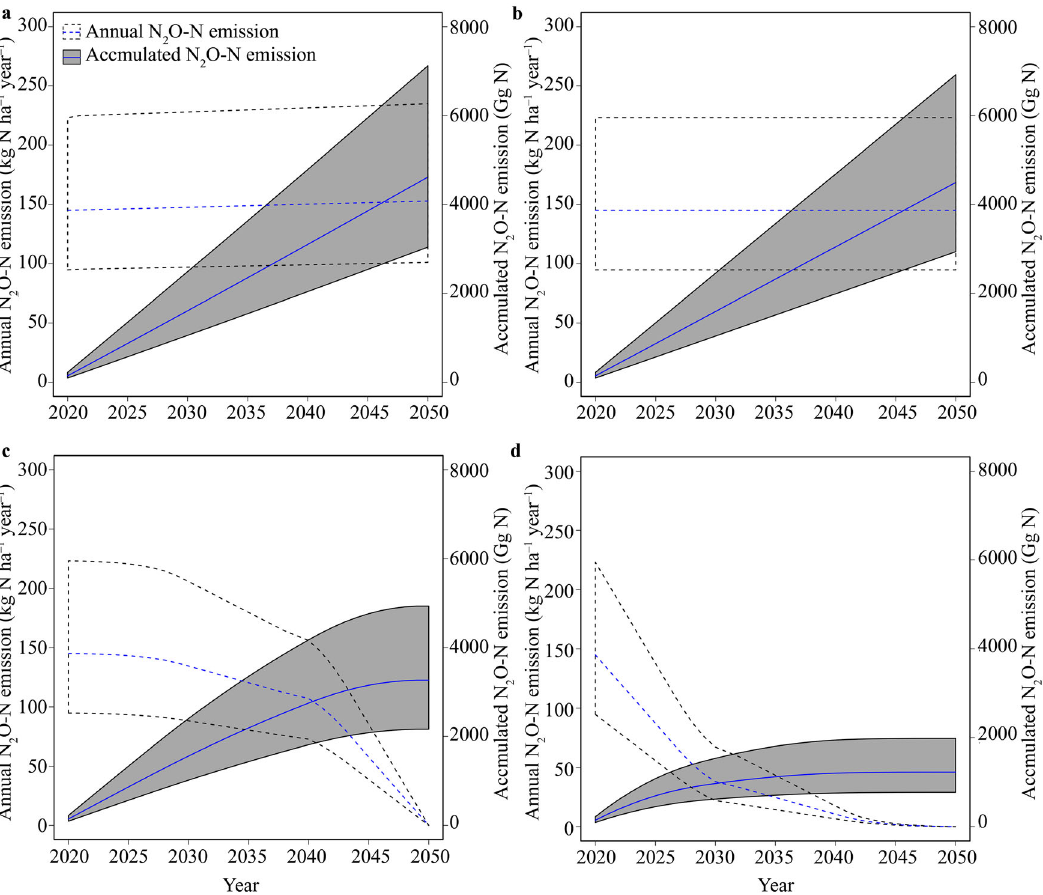
Fig. 2 Future annual and cumulative nitrous oxide (N 2 O-N) emissions from managed European peatlands (EU-28) under different scenarios. a The area of drained peatland will increase continuously; b the area of drained peatland remains constant; c rewetting, starting with lowly degraded peatlands; d rewetting, starting with highly degraded peatlands. The shaded areas indicate 95% con fi dence intervals.